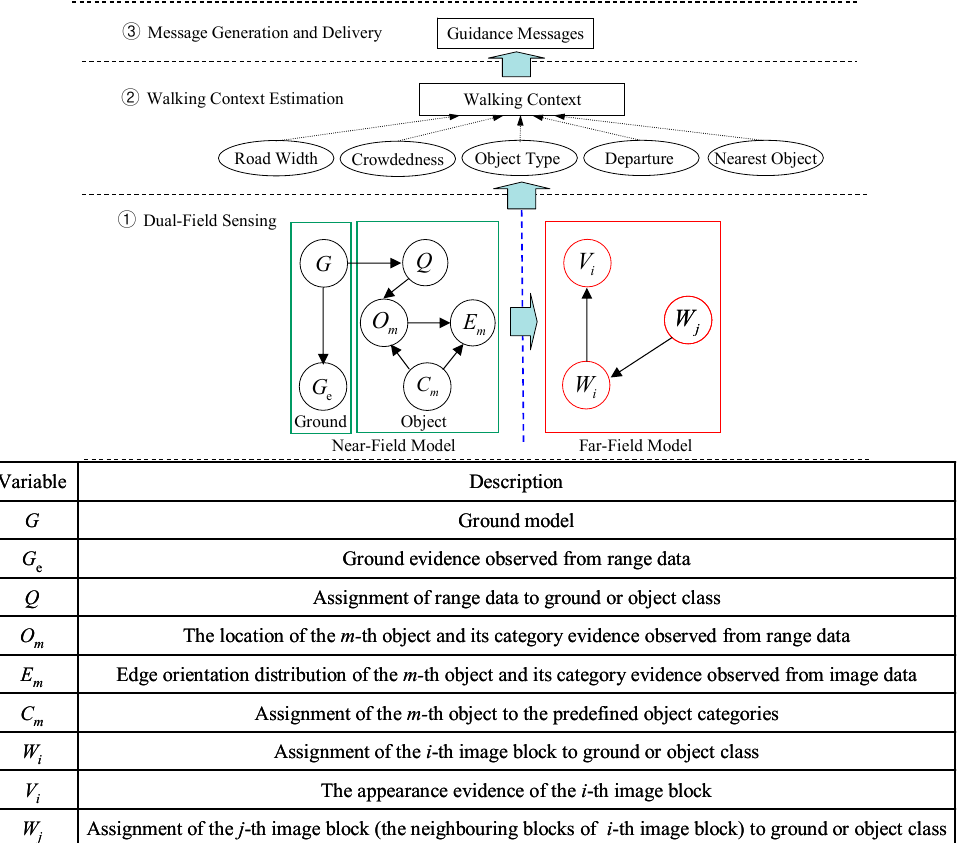
Figure 2. Guidance system model.